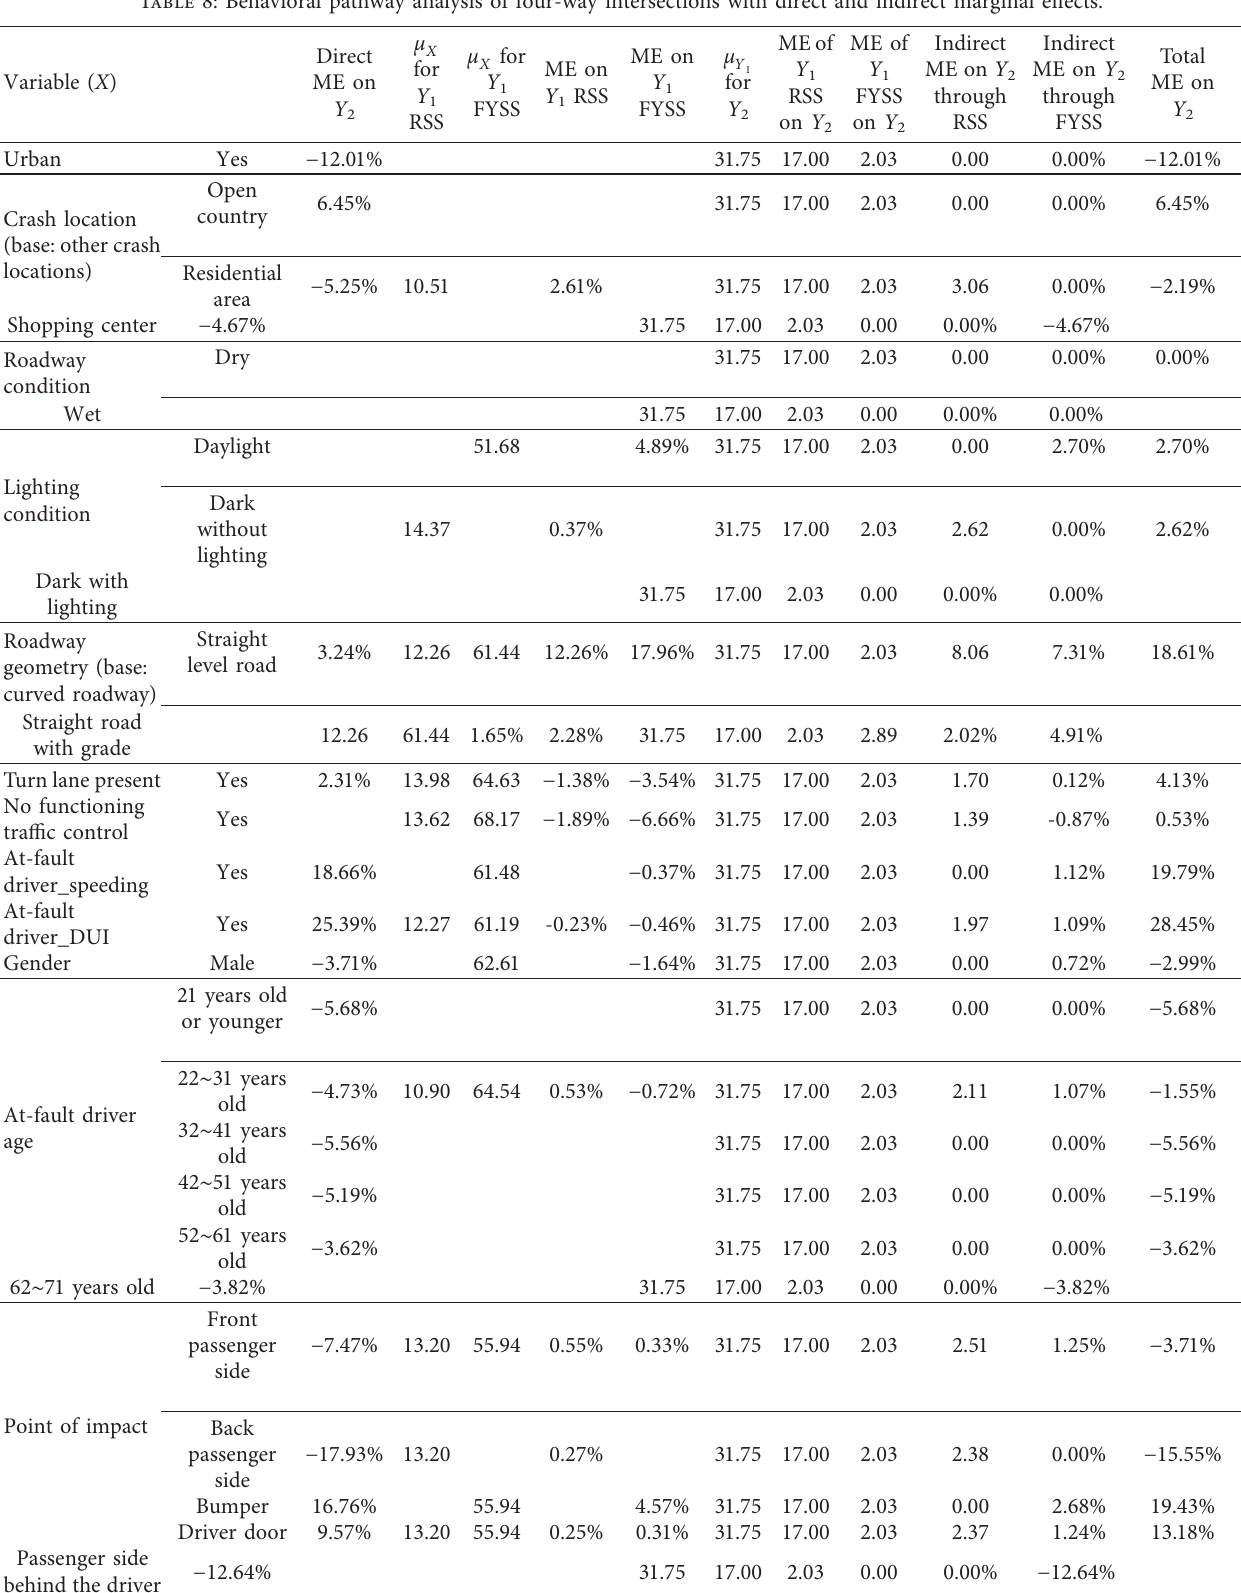
Table 8: Behavioral pathway analysis of four-way intersections with direct and indirect marginal